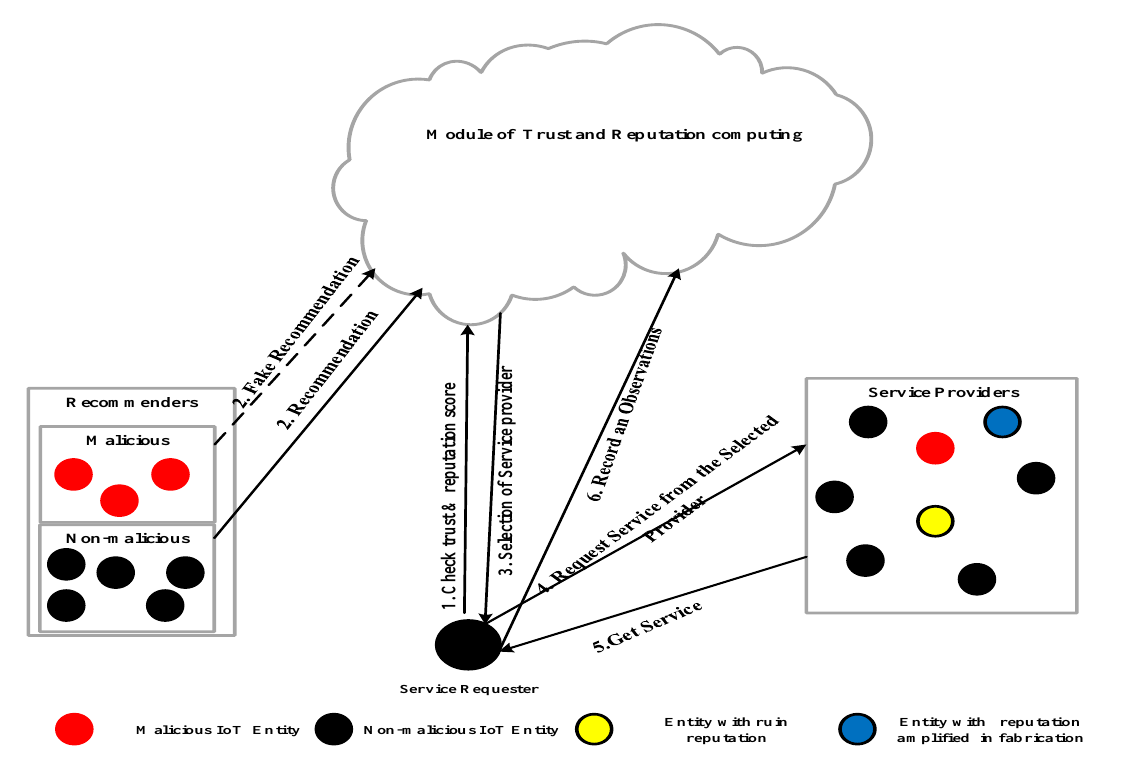
Figure 2. Trust-based SP selection in IoT [30].